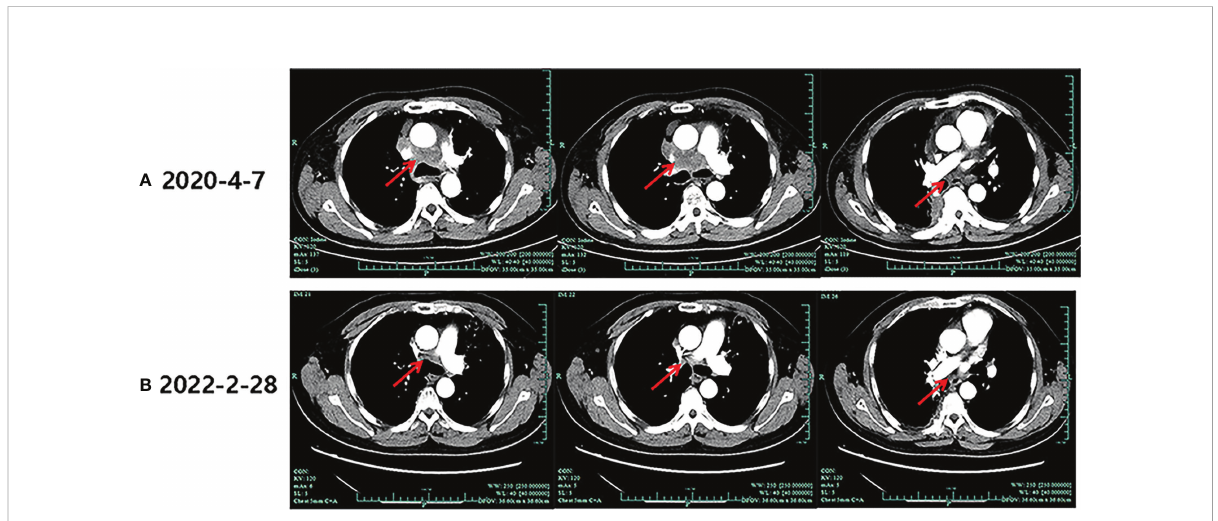
FIGURE 1 Imaging evolution of the patient. (A) The baseline computed tomography scan of alectinib treatment. (B) Computed tomography scan of the last follow-up of alectinib